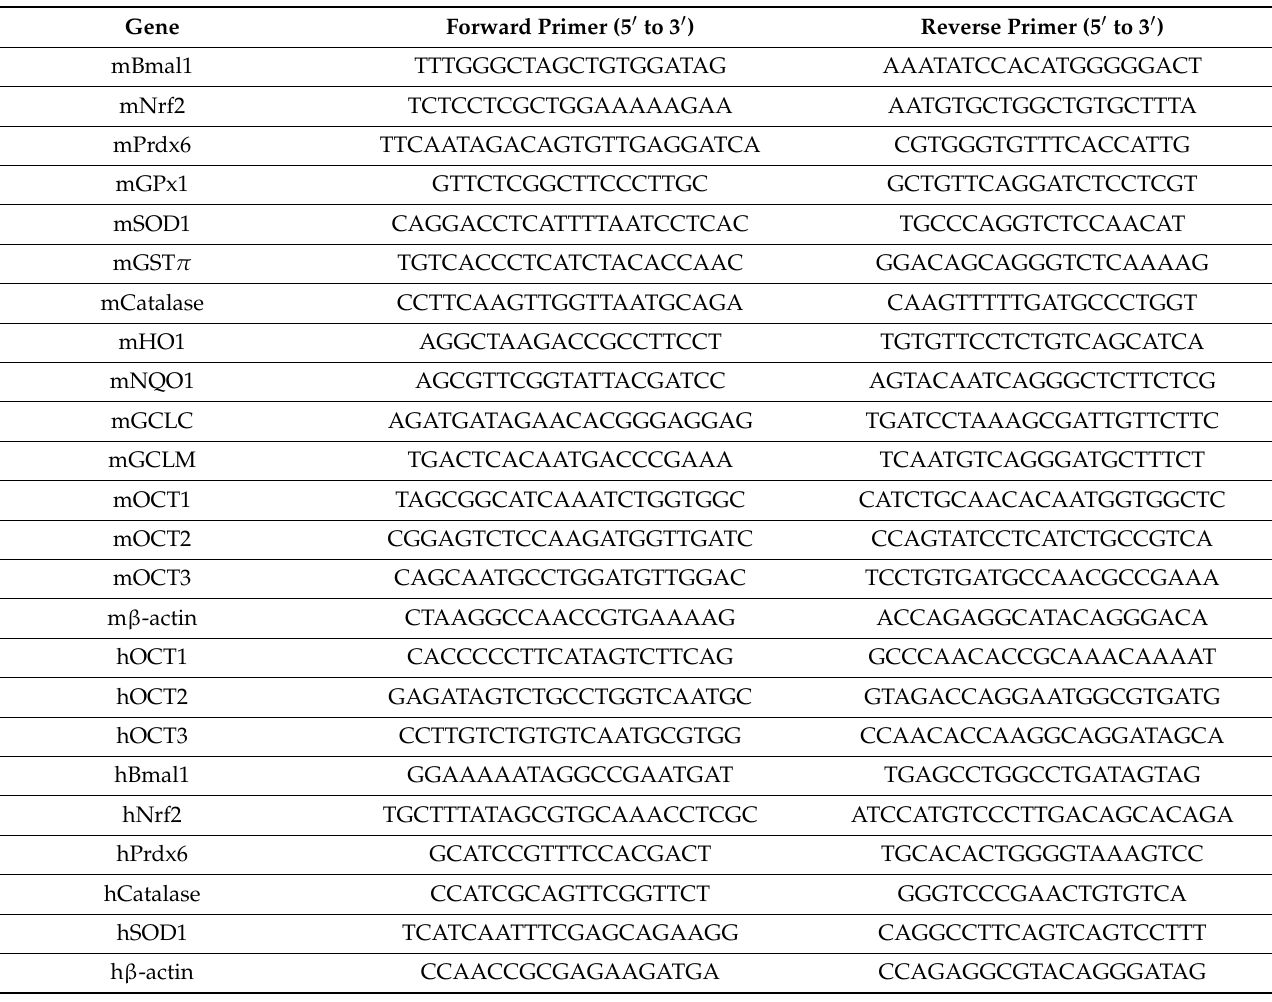
Table 1. RT-qPCR